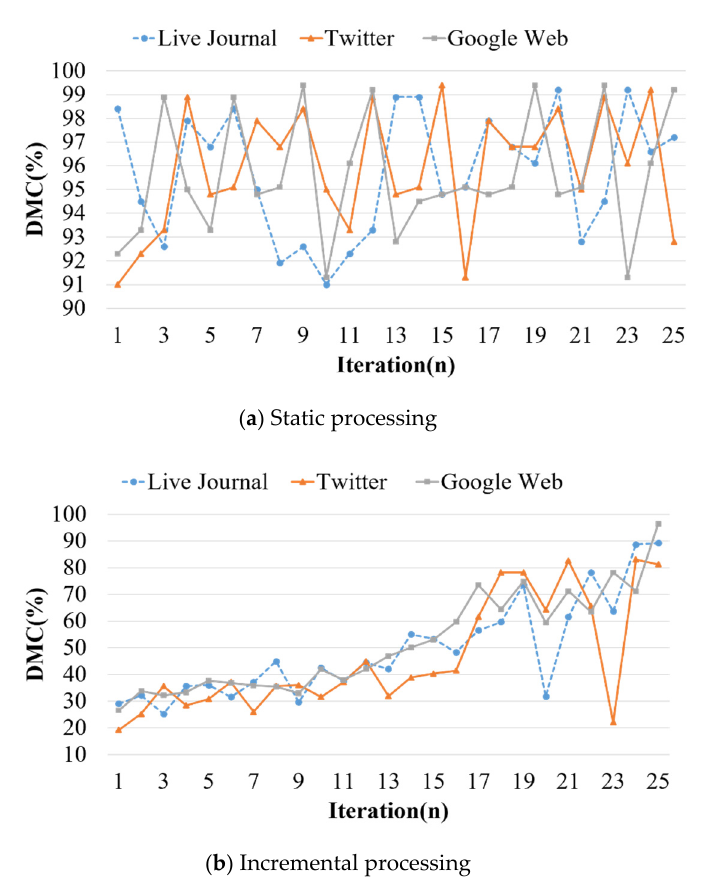
Figure 8. Decision-making capability of static processing and incremental processing.